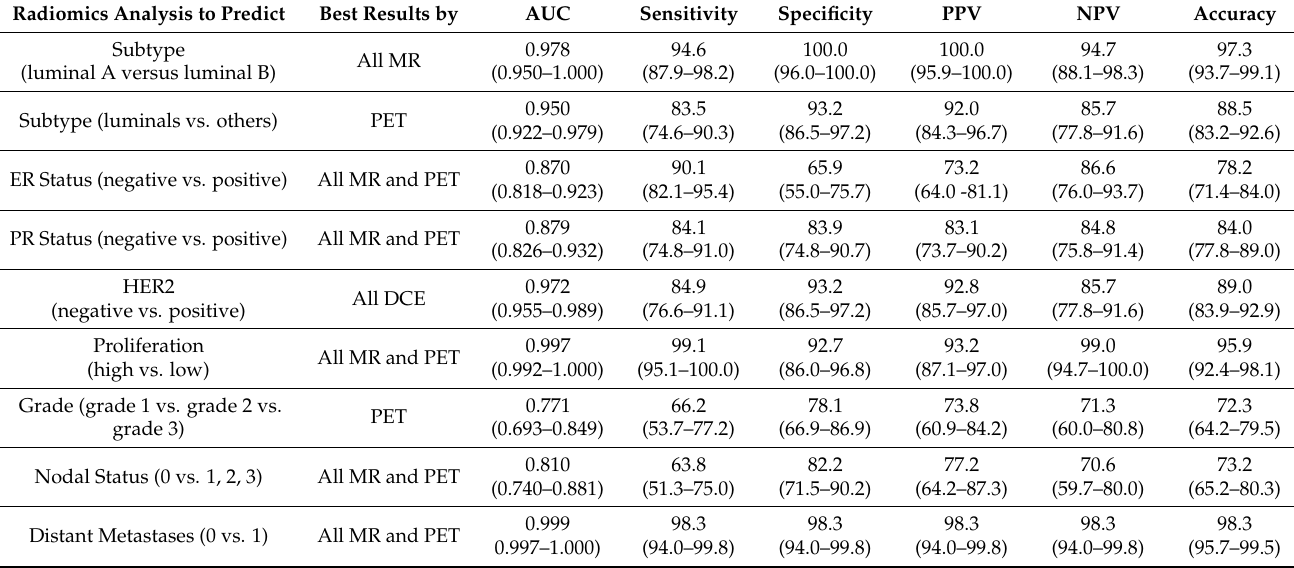
Table 2. Selection of best mean classification accuracies achieved for prediction of each assessed imaging biomarker. Radiomics Analysis to